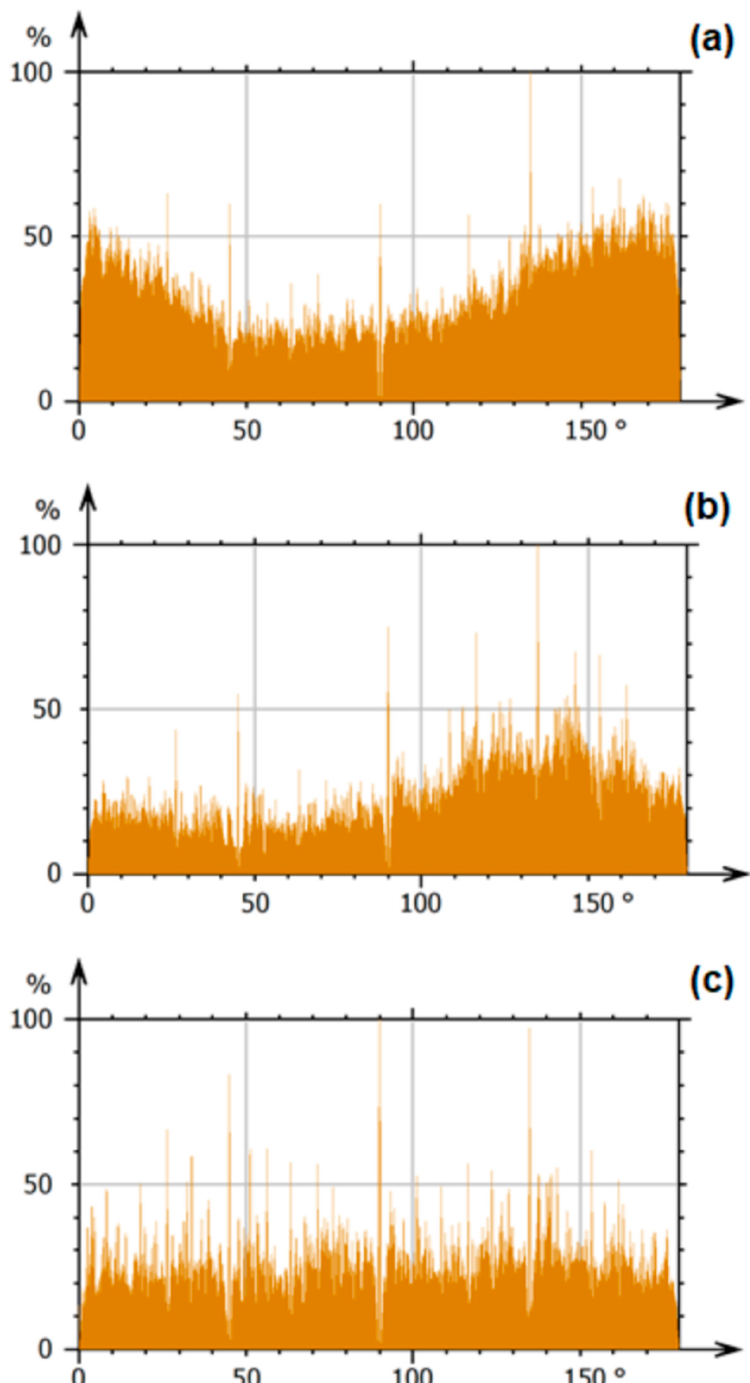
Figure 4. Texture directions of surface microtexture of ( a ) GdMnO650, ( b ) GdMnO750, and ( c ) GdMnO850.